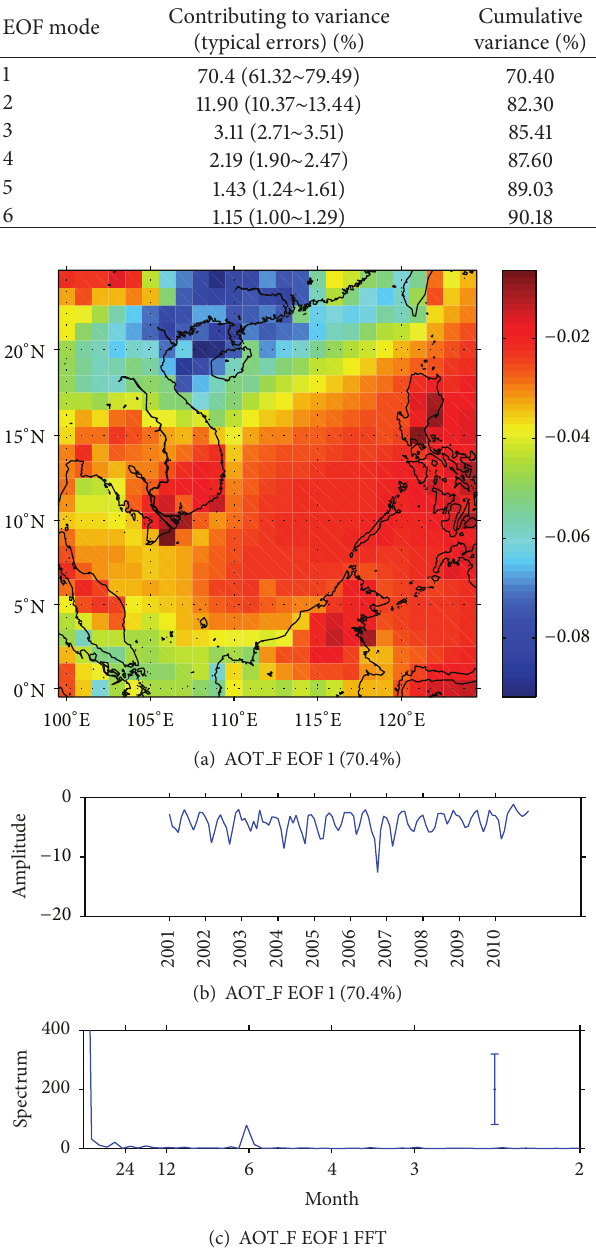
Figure 5: (a) The spatial distribution, (b) its corresponding time- varying amplitude for the vector EOF analysis mode 1 of the AOT F in SCS during 2001/1–2010/12, and (c) the spectrum of (b) with FFT. The line segment represents the 95% confidence